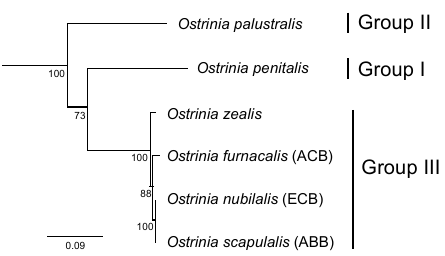
Figure 1. The phylogeny of six Ostrinia species, adapted from [14]. The maximum likelihood tree was built based on 13 protein-coding genes from the mitogenomes. Percentage bootstrap support (N = 1000) values are shown at corresponding nodes. Scale bar indicates nucleotide substitutions per site. The classification of groups according to the number of uncus lobes in male genitalia are labelled on the right side.